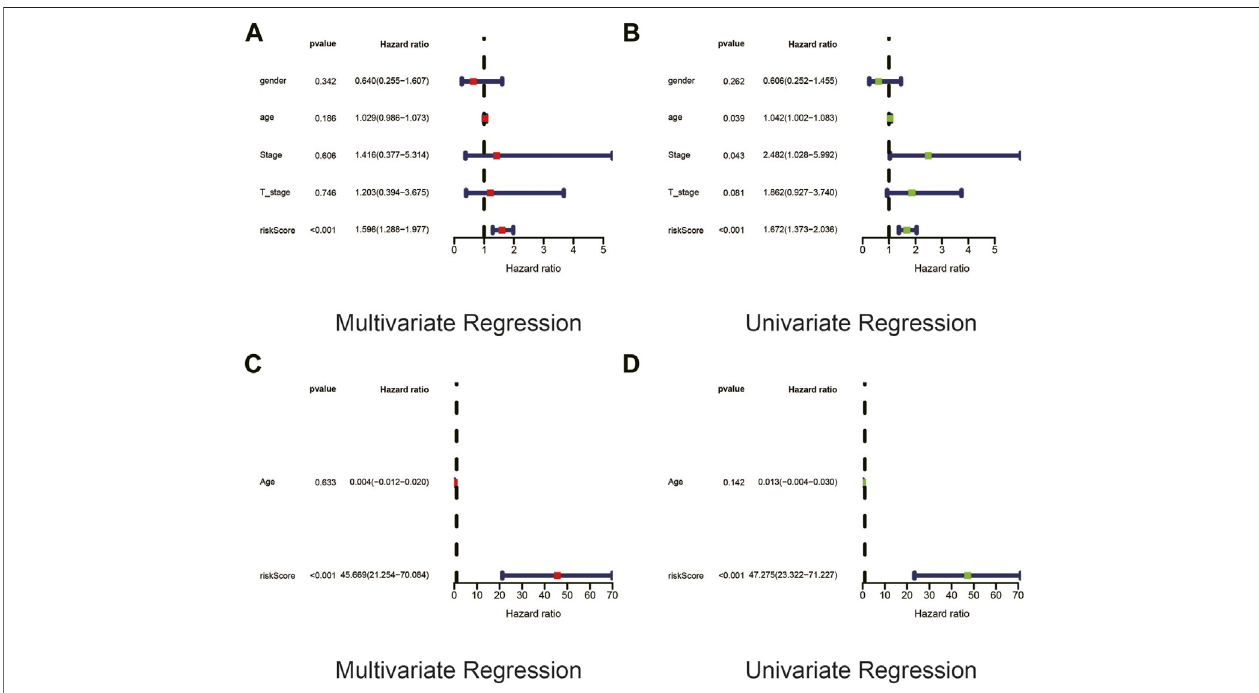
FIGURE5| Univariateand Multivariate Coxregressionrevealedthattheriskscorewasanindependent prognosticfactorinUVMpatients. (A,B) Inordertoexplore whether risk score was an independent in fl uencing factor for melanoma patients, univariate and multivariate Cox regression were performed for risk score, age, gender, TNM stage and other factors in both the training cohort and the validation cohort. Cox regression showed that risk score was a independent prognostic factor using univariate cox regression using both univariate (Panel 5A) and multivariate (Panel 5B) regression, despite the fact that tumor stage could also be considered as an independentprognosticfactor bymeansofunivariatecoxregression.( C,D )Likewise,riskscorewasalsoanindependentprognosticfactorwithstatisticalsigni fi cancein validation cohort.